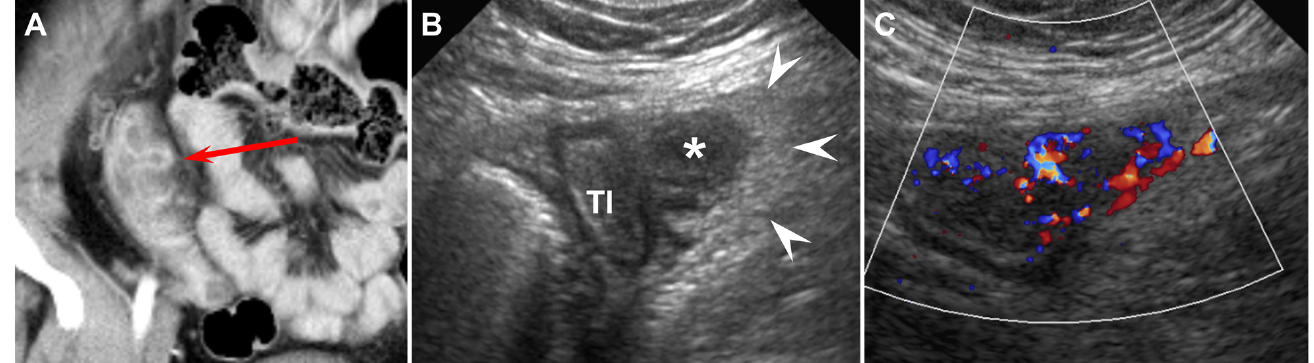
Table 2. CT fi ndings for acute ileal diverticulitis.